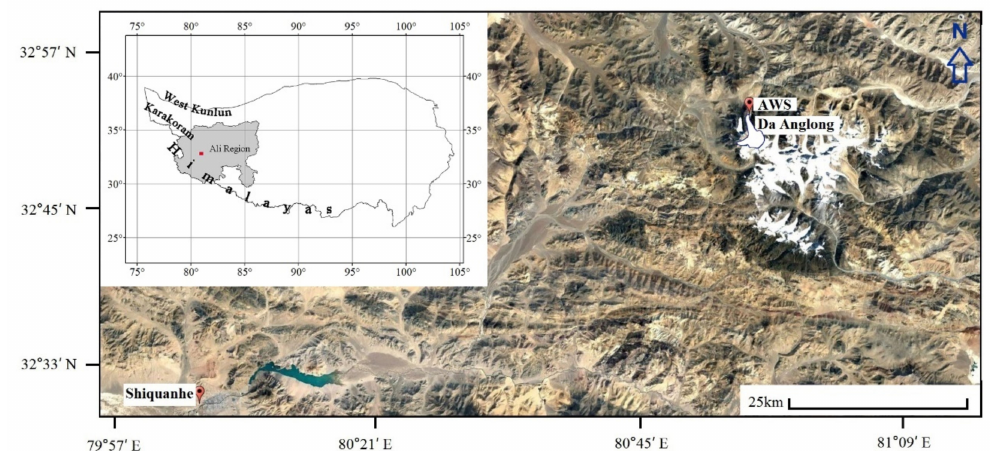
Figure 1. The location and image from Google Earth of Da Anglong Glacier, the Shiquanhe station and the AWS. The inset map displays the outline of the Tibetan Plateau, our study region (red box), locations of Ali region, West Kunlun, Karakoram, and Himalaya.